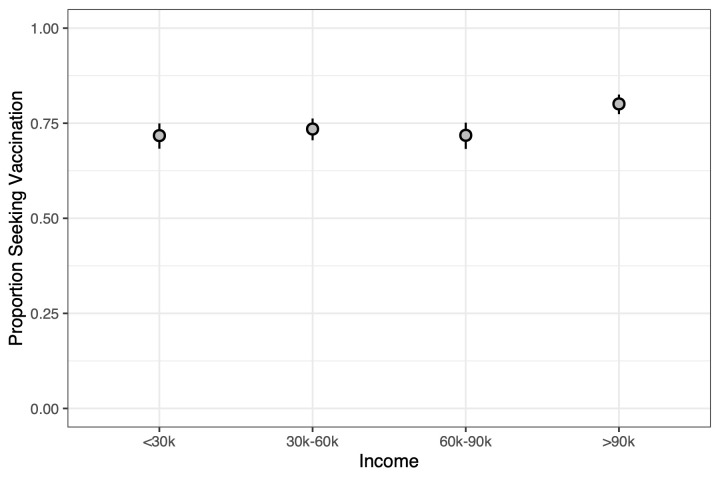
Comparing different levels of income in their proportion to seek vaccination across ages.Populations with family incomes above $90,000 are significantly greater in their proportion to seek vaccination than others, particularly in the 50-year-old and 60-year-old age groups. Whiskers from the points are the 95% confidence intervals.